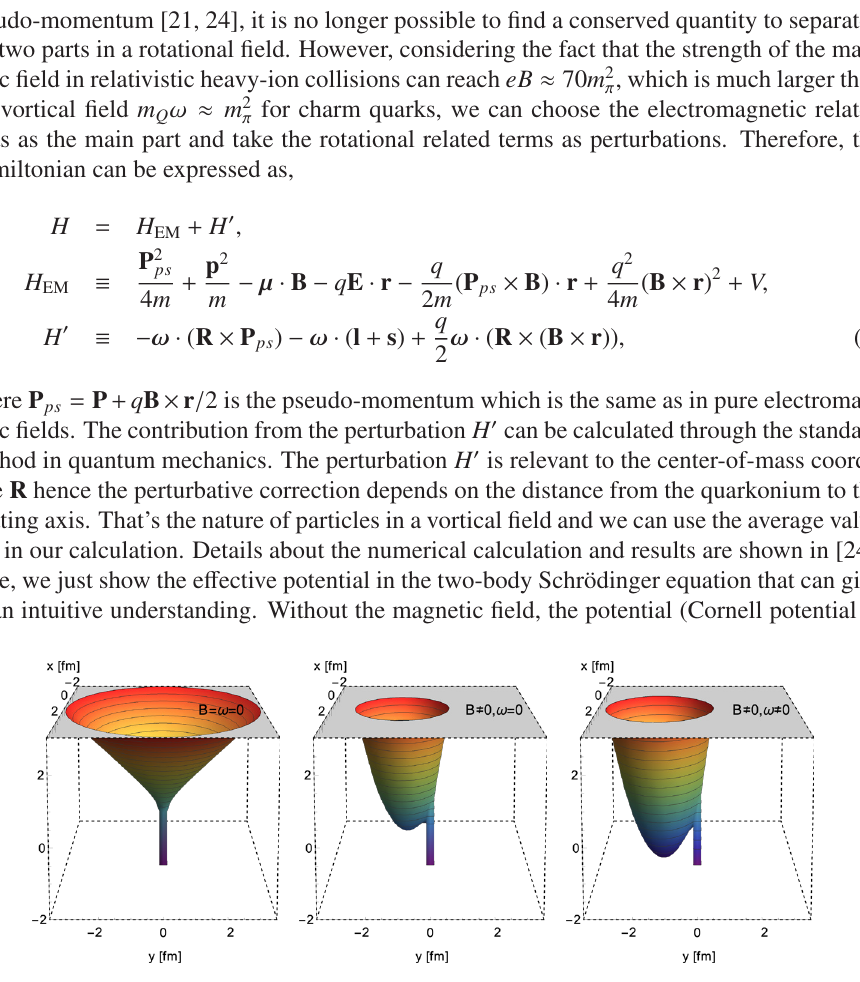
Figure 1. Spin-independent vacuum interaction potential between charm and anti-charm quark in x plane with z = 0 with / without magnetic and / or vortical fields. The unit of potential is GeV.